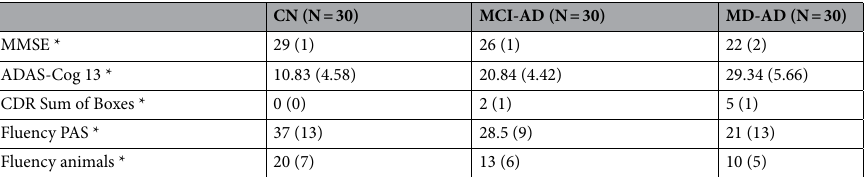
Table 2. Cognitive assessment results of the participants. MMSE, Mini-mental state examination; ADAS- Cog 13, Alzheimer’s Disease Assessment Scale-Cognitive Subscale; CDR, Clinical Dementia Rating. Data are represented as median and interquartile range. *All three groups differed significantly.